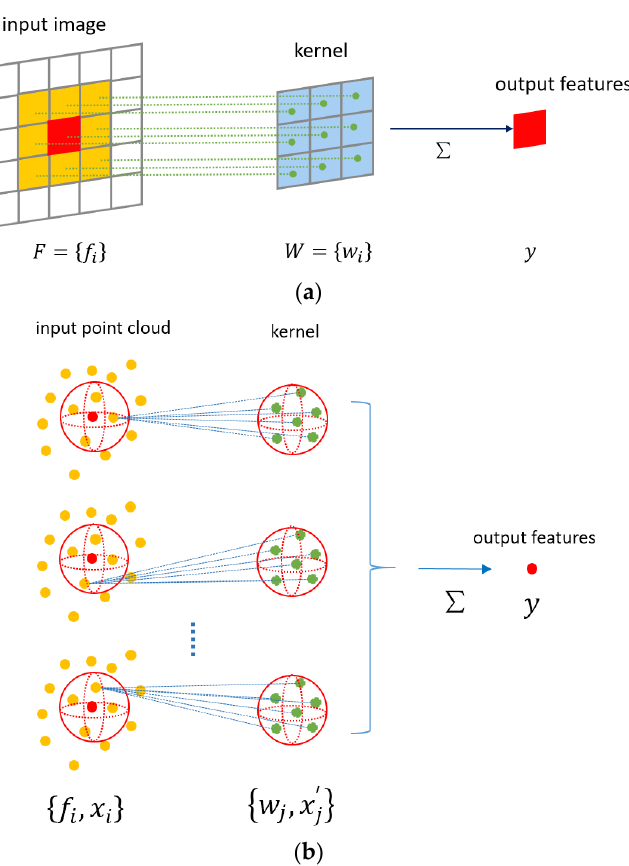
Figure 1. A brief description of the comparison between image convolution and point cloud convolution. ( a ) Image convolution: Each pixel of the input image corresponds to one kernel element. ( b ) Point cloud convolution: Each point within the local region is weighted to all kernel elements. In Equation (2), the aggregation function (cid:1827) is set as a summation operation, which